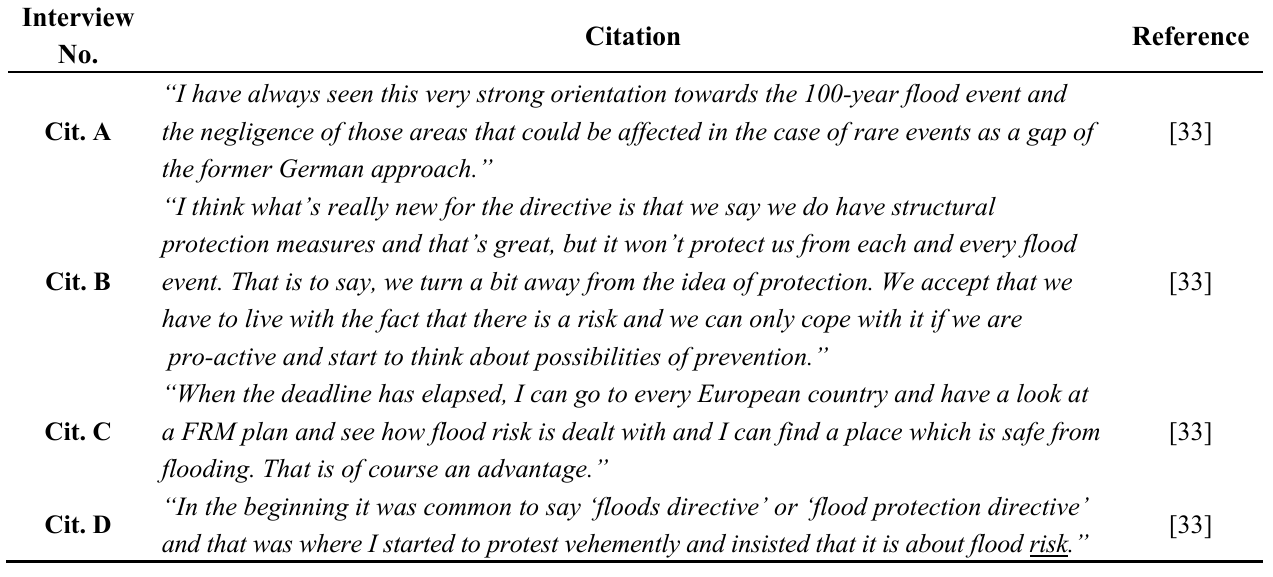
Table 2 . Citations showing acceptance of the FRM